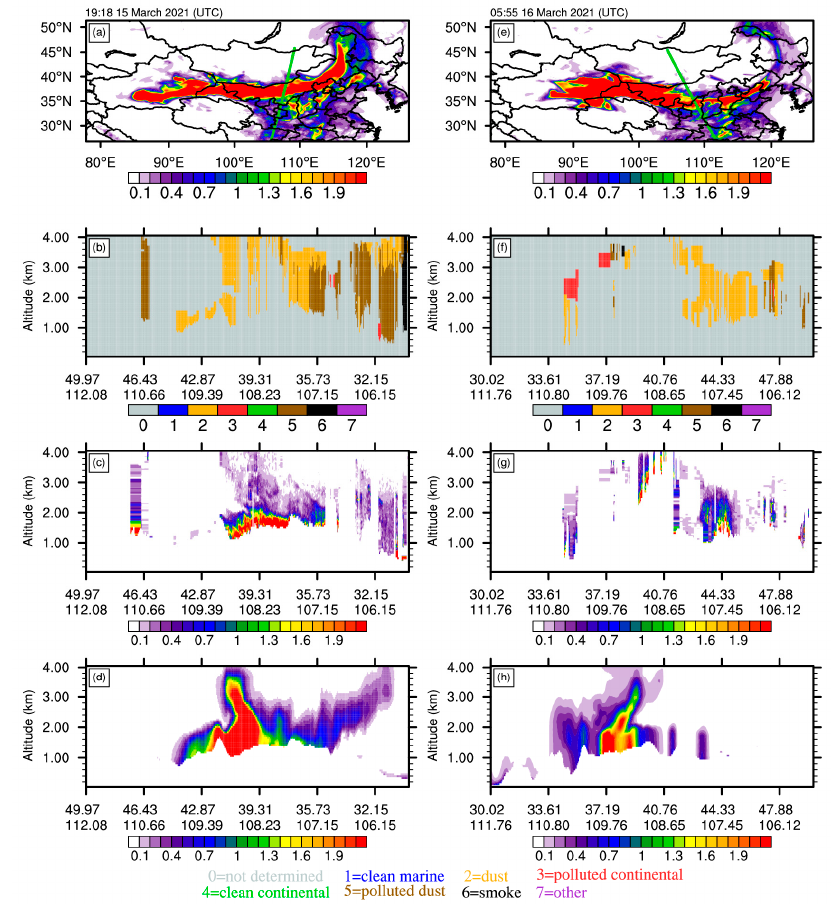
Figure 9. Spatial distribution of simulated AOD at 19:18 UTC on 15 March 2021 ( a ) and 05:55 UTC on 16 March 2021 ( e ). The green curves indicate the CALIPSO orbit paths (orbit 1 at 19:18 UTC on 15 March, orbit 2 at 05:55 UTC on 16 March). CALIPSO-derived vertical aerosol subtypes are ( b , orbit 1 scanned) and ( f , orbit 2 scanned). The CALIPSO-observed aerosol extinction coefficients (km − 1 ) at 532 nm are ( c , orbit 1 scanned) and ( g , orbit 2 scanned) and WRF-Chem simulated ones at 550 nm are ( d , interpolate orbit 1) and ( h , interpolate orbit 2) over the two CALIPSO orbit paths.